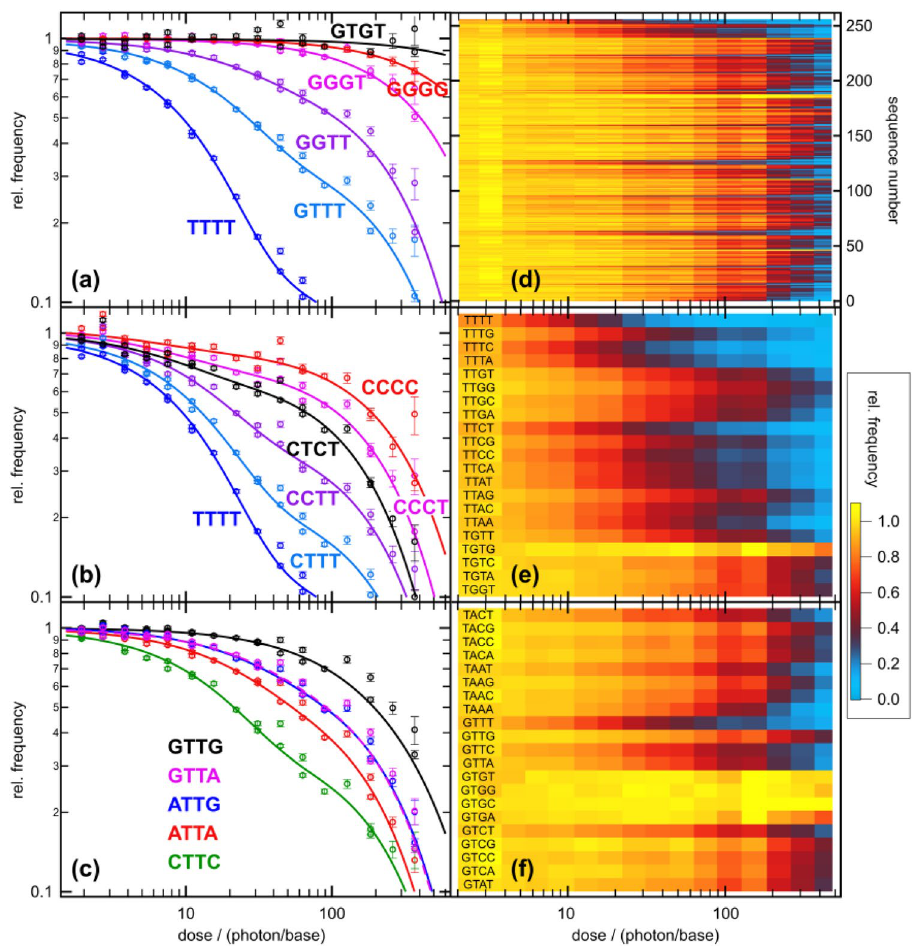
Figure 4. Relative frequencies of tetramer sequences as a function of UV-irradiation dose. ( a ) Sequences from TTTT to GTGT show the large range of decay constants. When several TT-dimers in the sequence exist, the possibilities to form T=T lesions lead to rapid decay of the relative frequency. ( b ) For combinations of thymine and cytosine bases in the tetramers there is always the possibility to form several CPD-lesions. There are clear indications for a bi-exponential behavior. ( c ) Relative frequencies for a selection of tetramer sequences containing a central TT dimer plotted as a function of UV-irradiation dose. When the TT-dimer is flanked by purines A or G the decay is much slower than for flanking C, where CPD-lesions are possible between all bases of the tetramer. The decay of GTTG is surprisingly slow, presumably due to the possible charge-transfer reaction between G and T, acting as an additional decay channel reducing damage frequency. ( d ) 2D-plot of the relative frequencies for all 256 tetramers. ( e ) and ( f ) expanded views for tetramers with a large fraction of fast decaying sequences (e) containing TT dimers and pyrimidine trimers. When GT or GC dimers are present (f) the decay is very